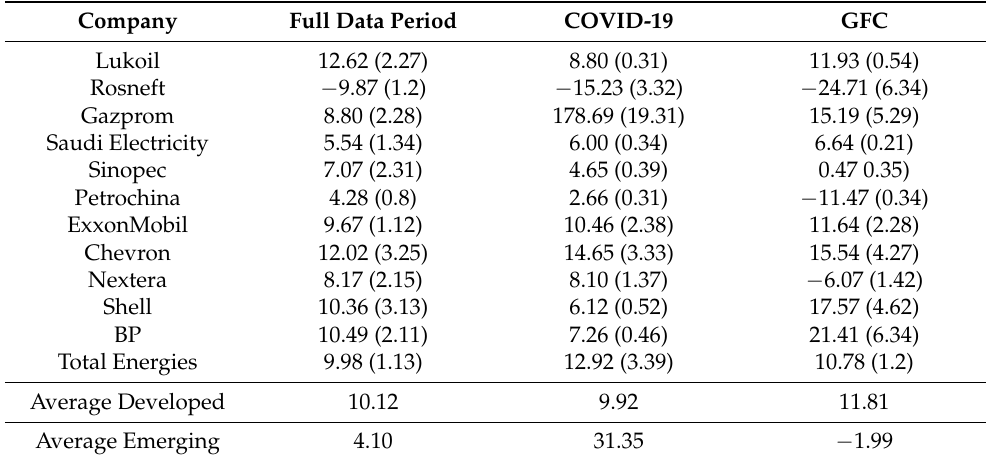
Table 4. Fama-French Five-Factor Cost of Equity Calculation for Leading Energy Companies in percent; standard deviation in